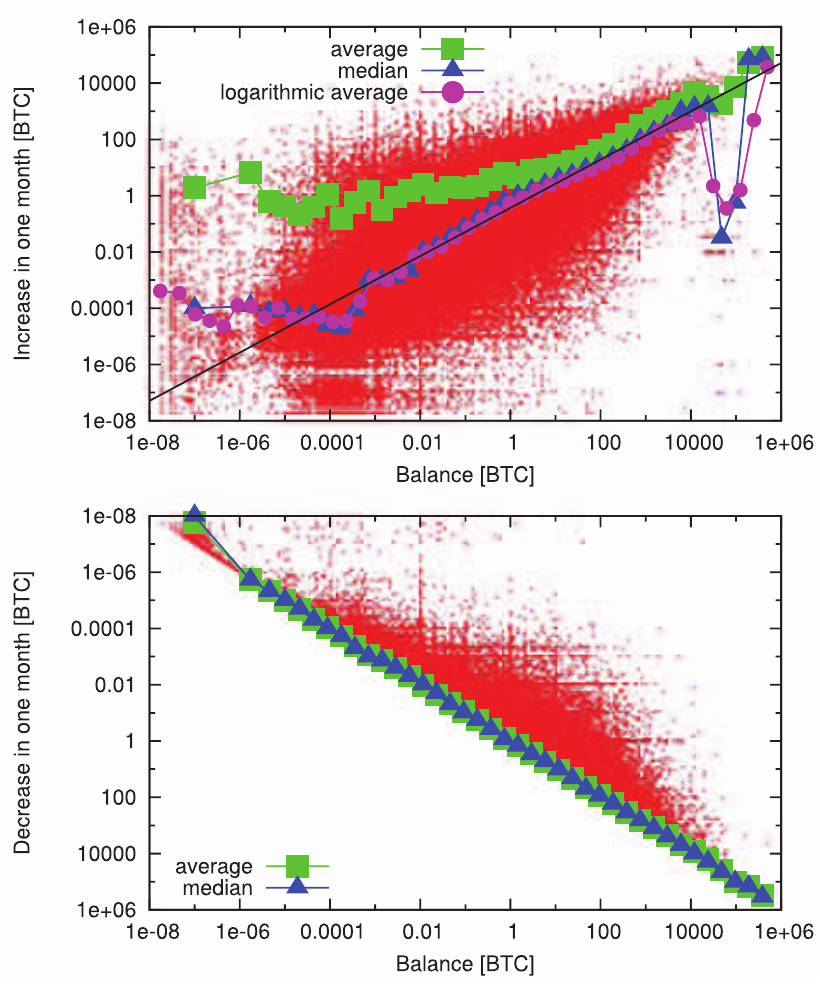
Figure 10. Change of balances in one month windows. Increase (top) and decrease (bottom, vertical axis is inverted) of node balances in one month windows as a function of their balance at the beginning of each month. We show the raw data (red), the average (green), median (blue) and logarithmic average (magenta). The later three are calculated for logarithmically sized bins. We find a clear positive correlation: addresses with high balance typically increase their wealth more than addresses with low balance. The median and the logarithmic average values almost coincide, which suggests multiplicative fluctuations. The median and the logarithmic average increase approximately as power-laws for several orders of magnitude. The black line is a power-law fit for the double logarithmic data; the exponent is 0 : 857 .